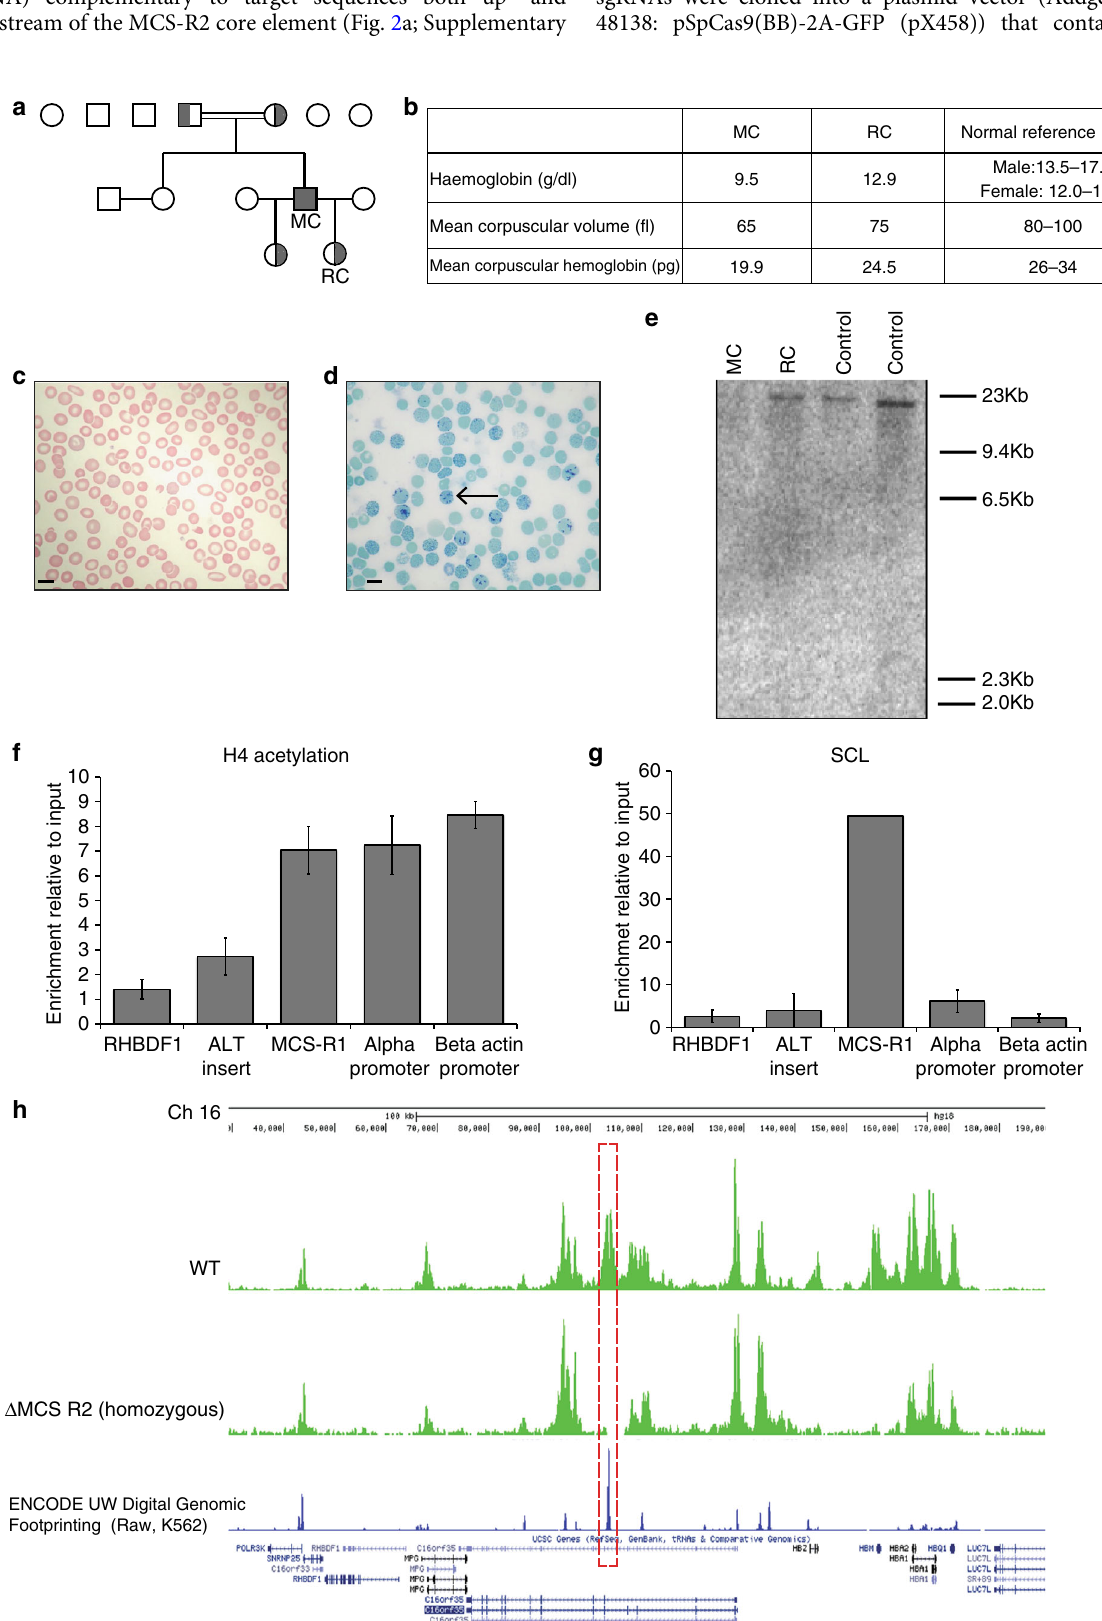
Table 2) to generate CRISPR plasmid pairs to use in combination to create two double-strand breaks at either end of the enhancer. When repaired this should introduce targeted deletions.